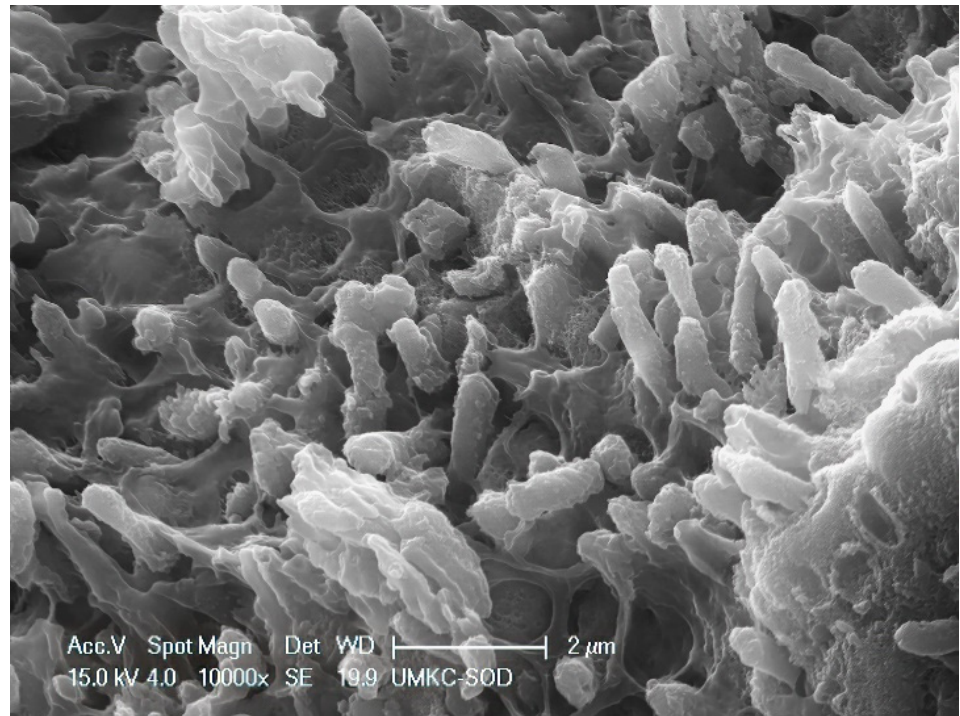
Figure 3. Untreated root surface at high magnification showing biofilm magnification view of biofilm microbes embedded in the extracellular matrix. In this view, most of the microbes are a short rod morphotype of ≈ 2 μ m length. Original magnification of 10,000×; Bar = 2 μ m. SRP-only specimens were characterized by a parallel pattern of instrumentation streaks and a smear layer (Figure 4). At high magnification, the smear layer appeared to consist mostly of bacteria and cementum debris. In areas lacking a smear layer, it was common to find clusters of bacteria for varying morphotypes, e.g., cocci, rods of various